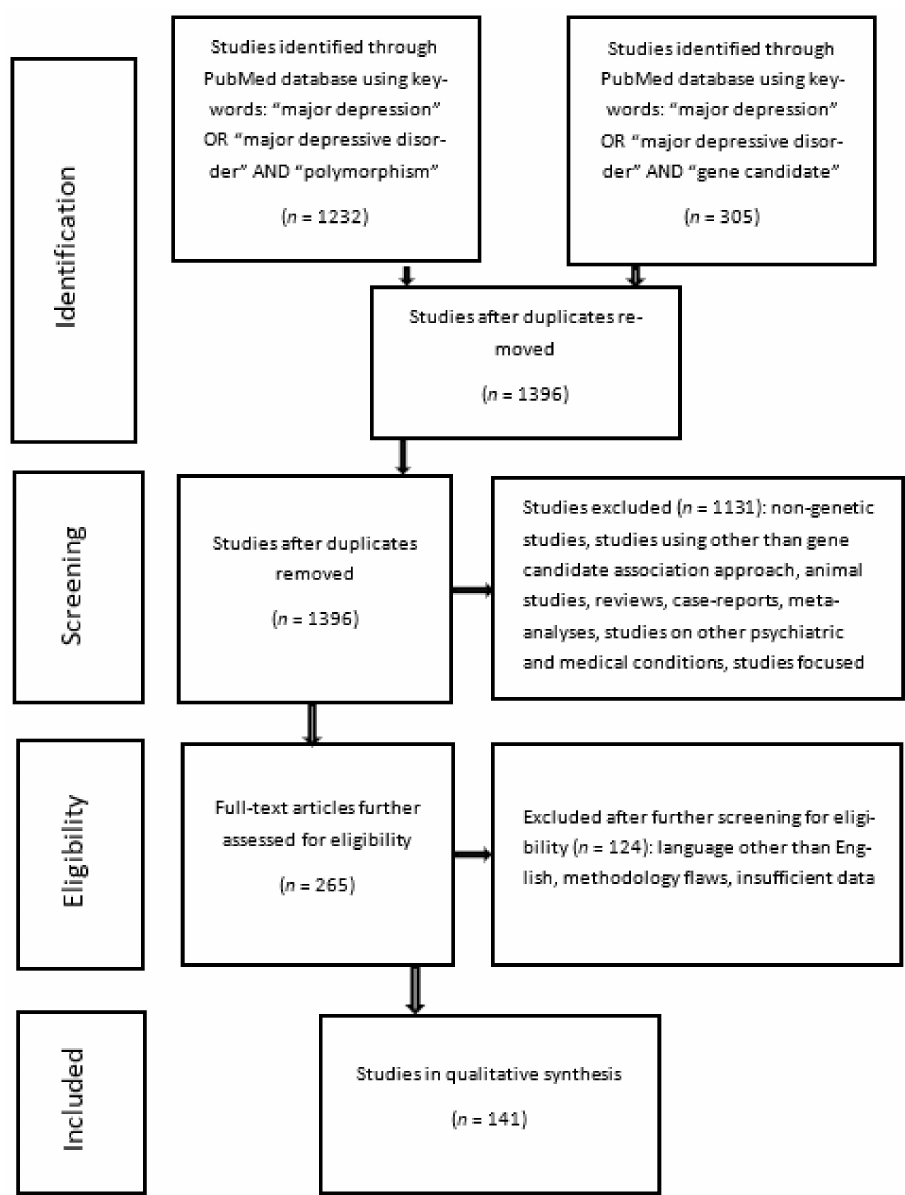
Figure 1. Flowchart of literature review